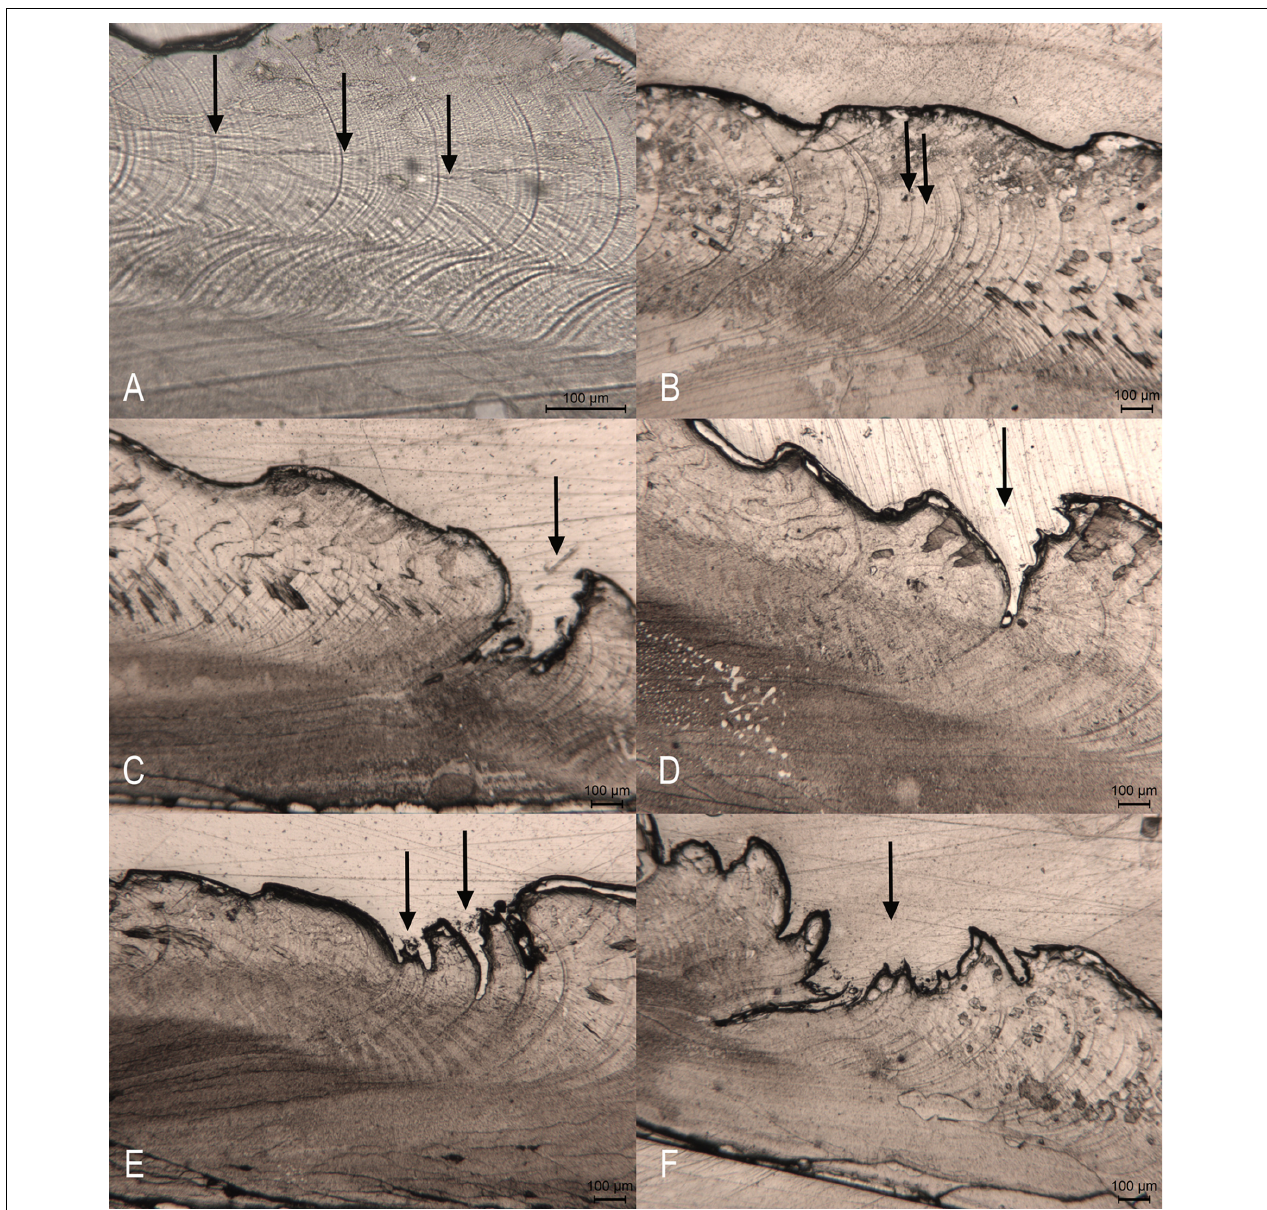
FIGURE 5 | Photomicrographs of acetate peel replicas of C. gallina shell sections. (A) Widely spaced and marked bands deposited during the fast growth period (arrows). (B) Narrower and less defined bands deposited during the slow growth period (arrows). (C,D) Annual growth ring with an associated cleft (arrow). (E) Annual growth ring with two occasional associated clefts (arrows). (F) A stress ring